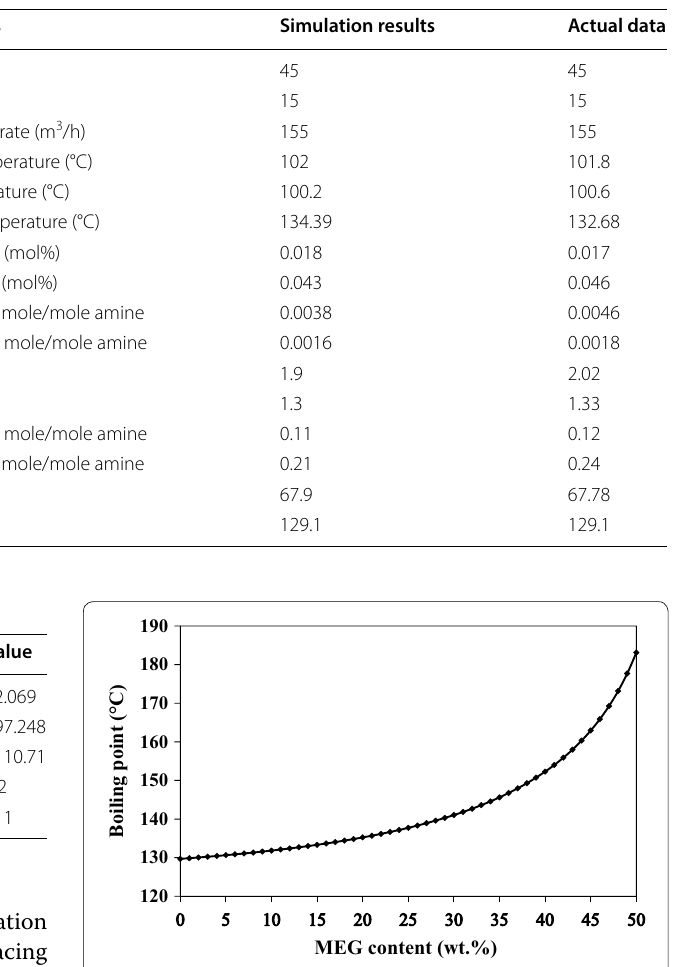
Fig. 3 Variation of boiling temperature of lean amine solution containing 45 wt% MEDA as a function of MEG